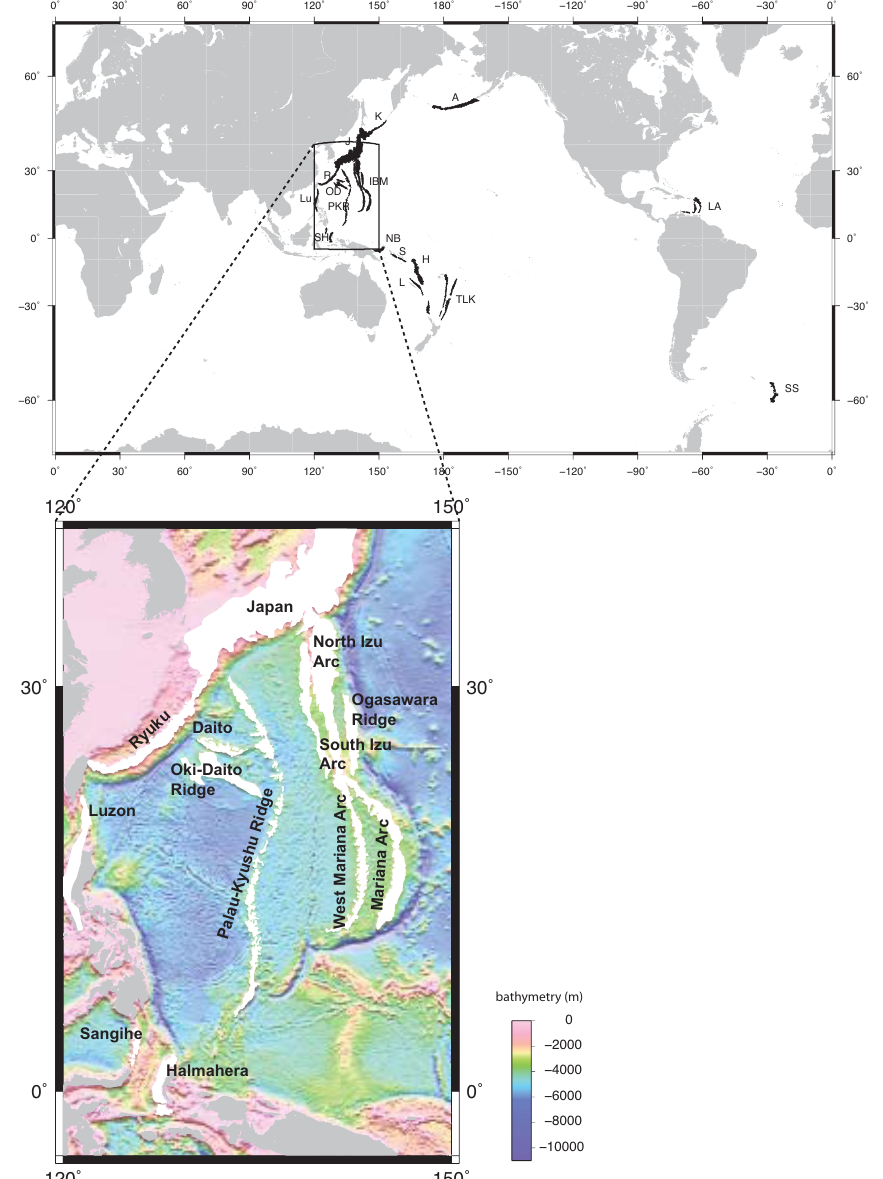
Figure 2. Global location map of island arcs (shown in black) on the present day ocean floor. Arc systems labeled on the map